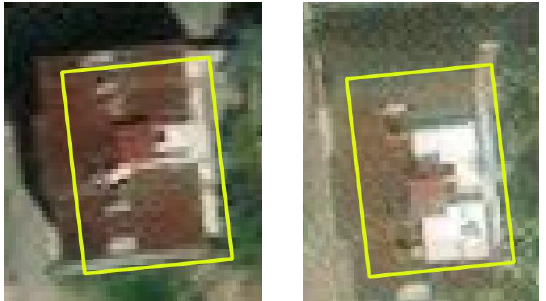
Figure 14. One example from False positive result. Yellow: Vector dataset.(Left: Pre-EQ, righ: